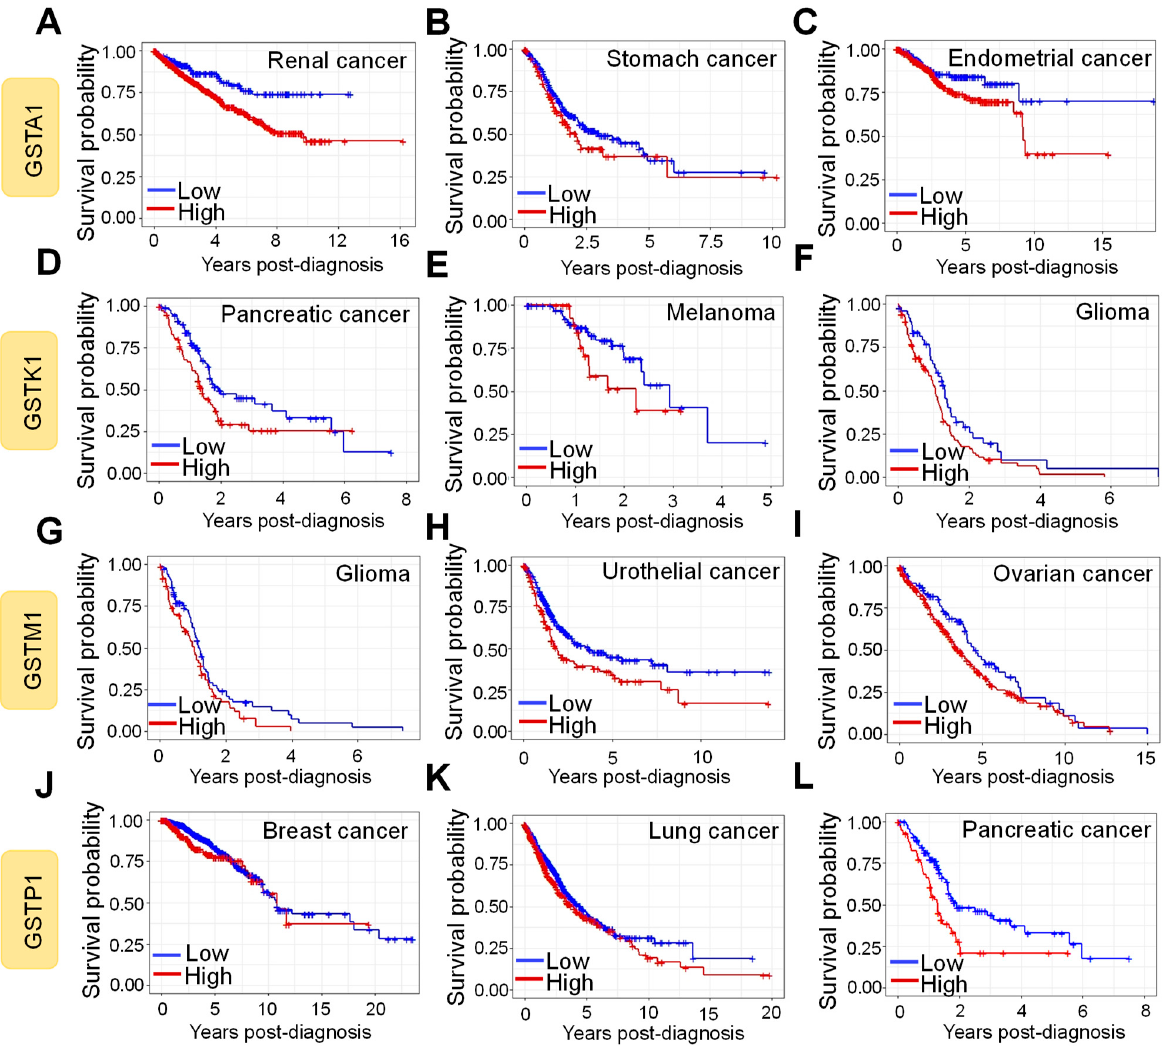
Figure 8. Expression of GST proteins is negatively correlated with patient survival for some human cancers. The Human Protein Atlas was mined for Glutathione S-transferase Alpha 1 (GSTA1) ( A – C ), Glutathione S-transferase Kappa 1 (GSTK1) ( D – F ), Glutathione S-transferase Mu 1 (GSTM1) ( G – I ), and Glutathione S-transferase Pi 1 (GSTP1) ( J – L ) mRNA expression in cancer patients relative to their corresponding years of survival post-diagnosis. The patients were divided in high- (red) and low- (blue) GST expressing groups. The Kaplan–Meier survival plots were constructed in RStudio.